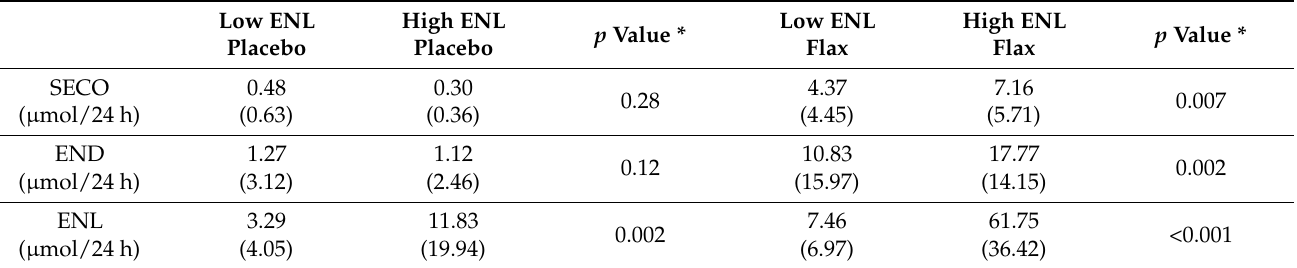
Table 1. Urinary lignan excretion (over 24 h) of SECO, END and ENL at the end of the placebo and